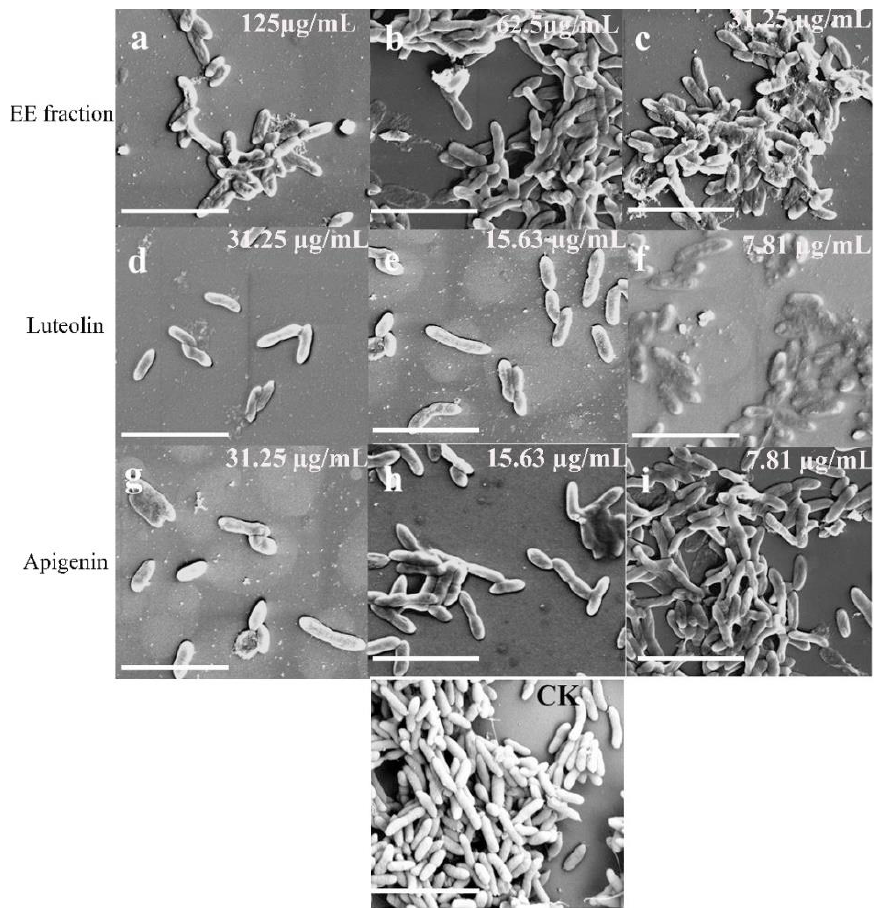
Figure 4 . Inhibiting effect of apigenin, luteolin, and EE fraction on the biofilm formation of C. violaceum by SEM. (CK) Biofilm formation of C. violaceum was quantified at OD 490 at mg/mL 30 °C after